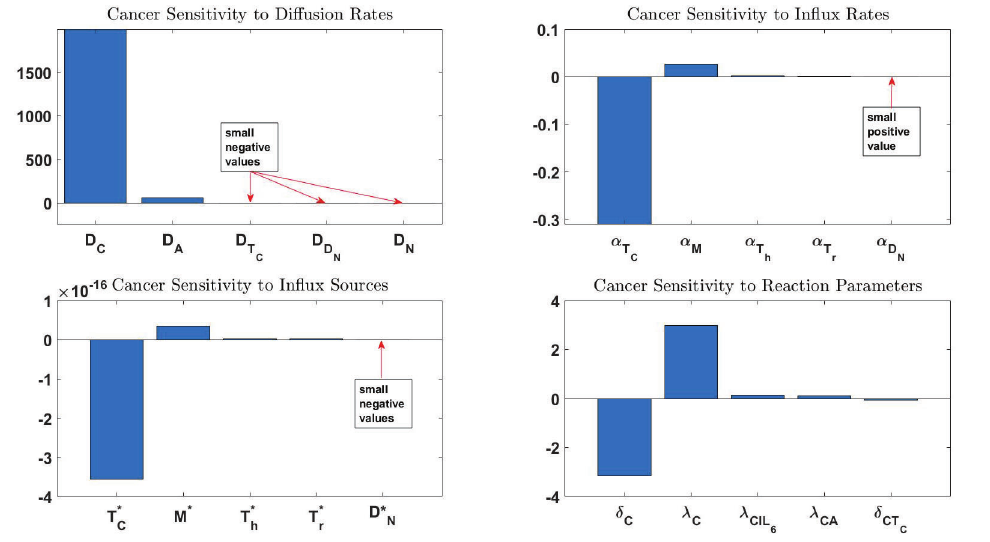
(cid:82) Figure 11. The sensitivity of Ω Cdx at t = 600 to four categories of parameters: diffusion rates, influx rates, influx sources, and the reaction